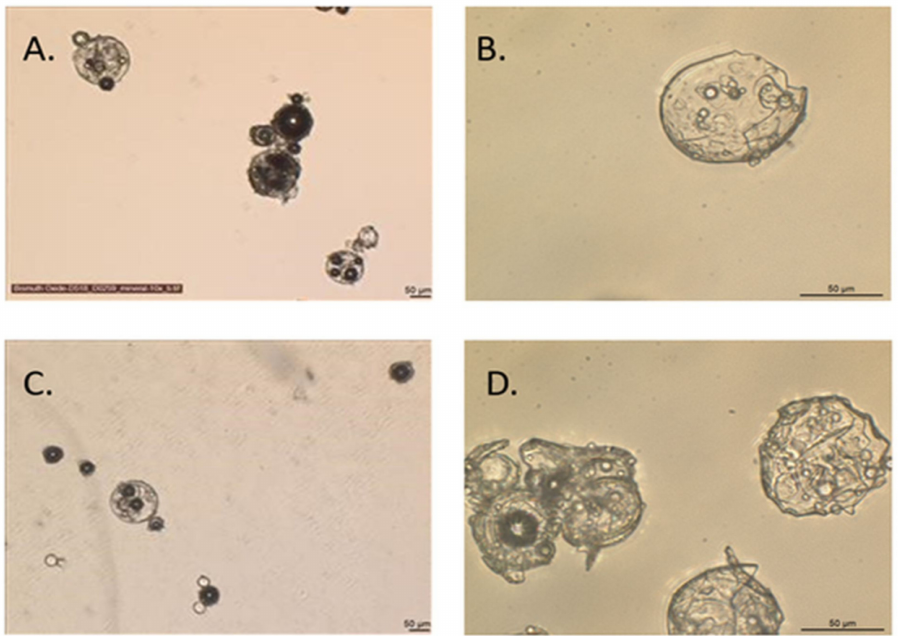
Figure 7. Optic microphotographs of original bismuth oxide API using 10 × magnification objective lens ( A ) and 40 × magnification objective lens ( B ), and after treatment with acetonitrile and subse- quently with DMSO particles using 10 × magnification objective lens ( C ) and 40 × magnification objective lens ( D